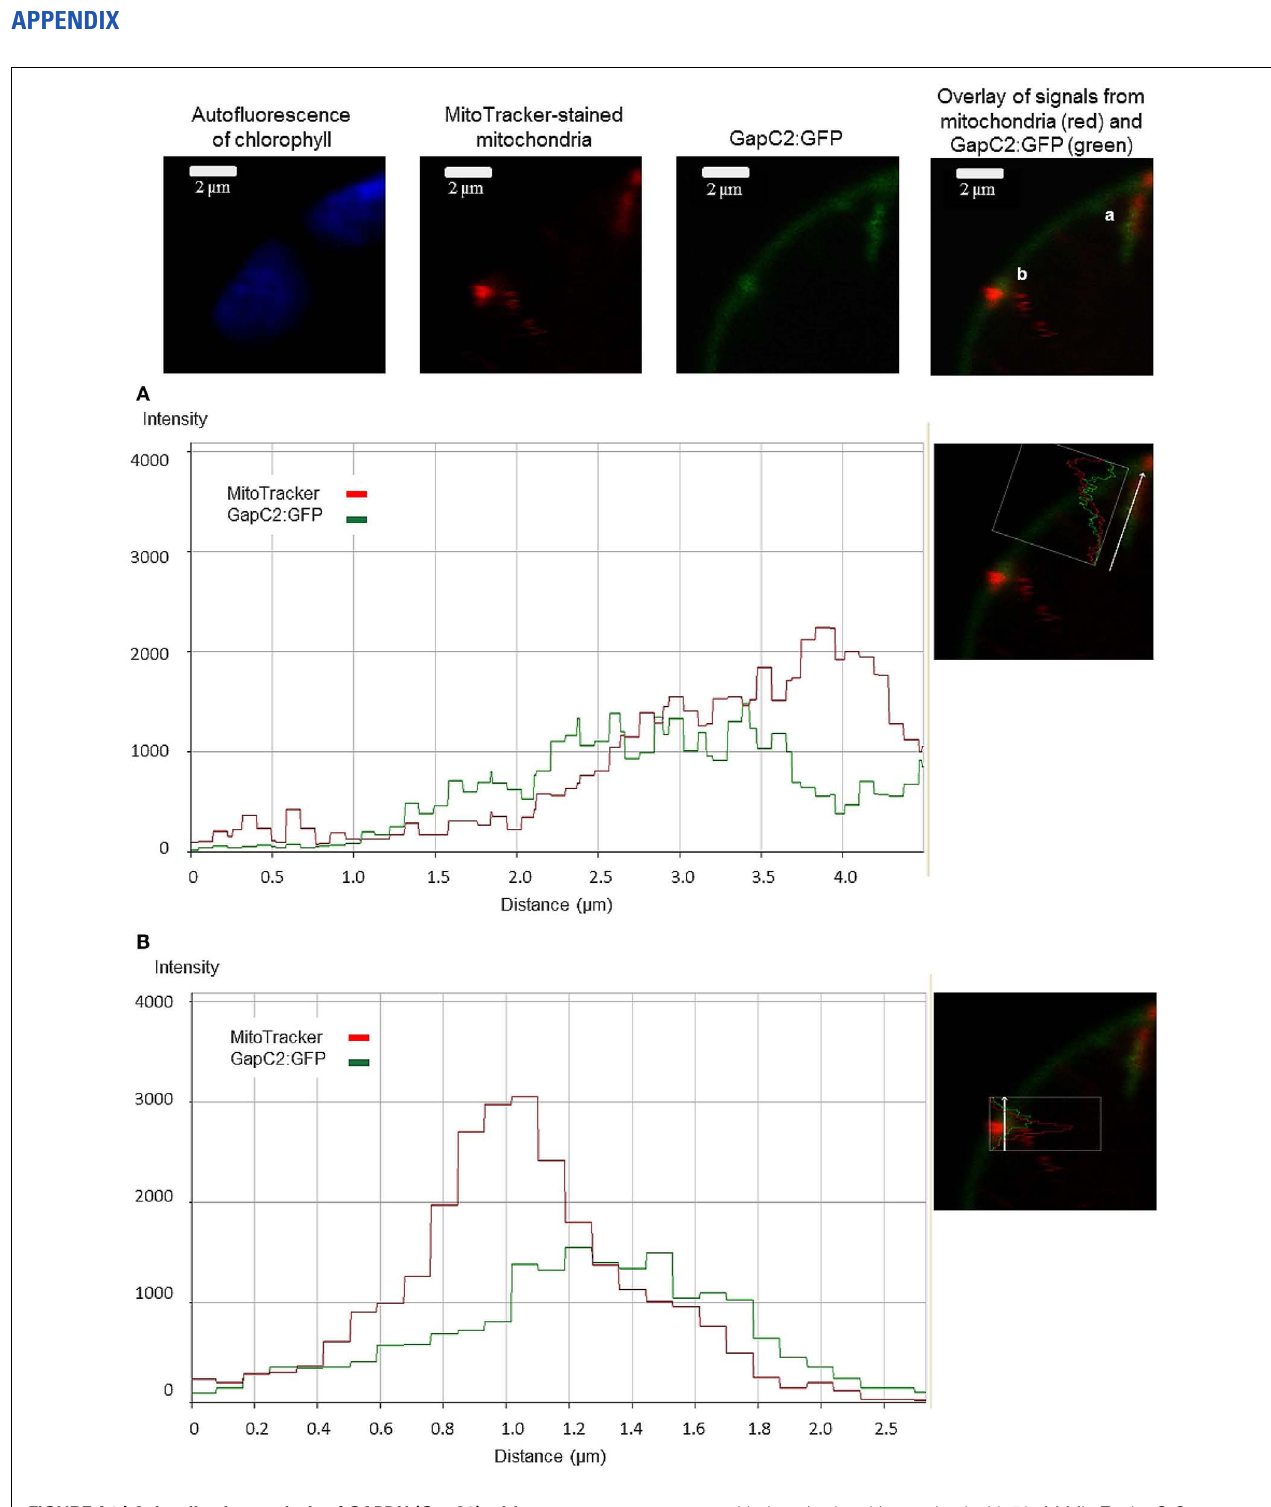
FIGUREA1 | Colocalization analysis of GAPDH (GapC2) with mitochondria. The magnified section of the protoplast expressing GapC2:GFP displays regions of a possible association of the glycolytic